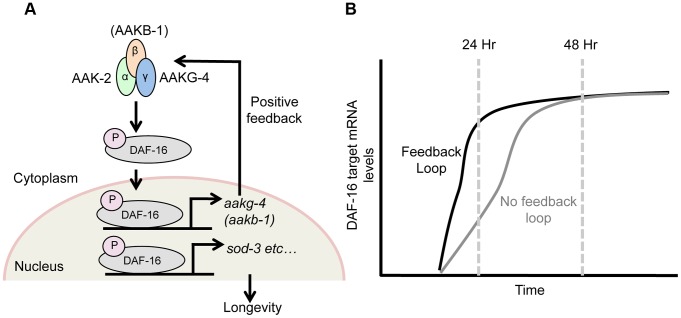
DAF-16 and AMPK form a positive feedback loop.Schematic model suggested by combining findings presented here, and elsewhere [28]. A) AMPK phospho-activates DAF-16 [28] and directly controls the transcription of 2 AMPK subunits, aakg-4 and possibly aakb-1 (this study). This in turn further increases AMPK levels, which further activate DAF-16 and target gene expression, and so on, creating a positive feedback loop. This broadly affects expression of DAF-16 target genes (e.g. sod-3), including those that determine aging rate (though note that sod-3 itself does not affect aging [77], [78]. B) This feedback loop appears to speed up DAF-16-mediated induction of gene expression in response to reduced IIS, rather than altering final expression level.